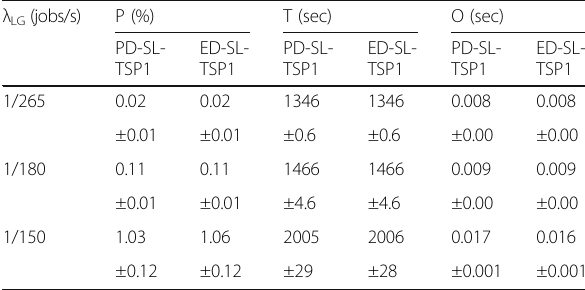
Table 2 LIGO workload: effect of λ LG on P , T , and